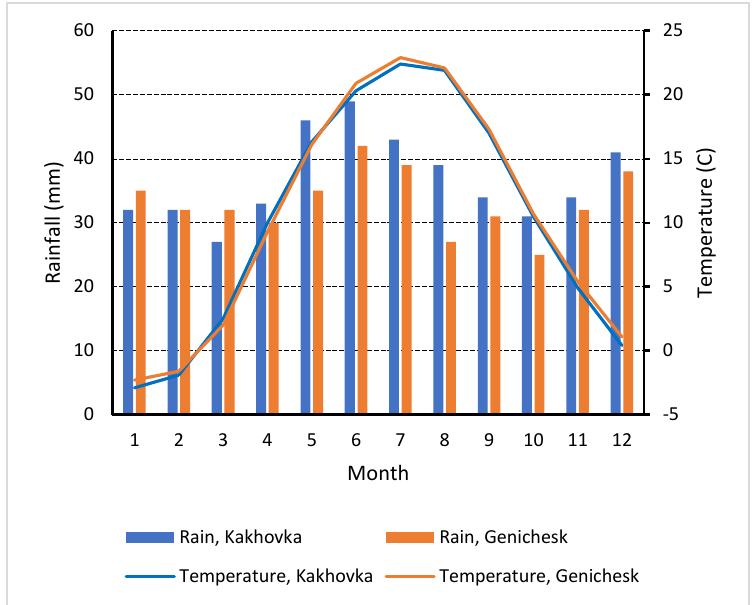
Figure 1. Average temperatures and rainfall (during the five years of experiments).